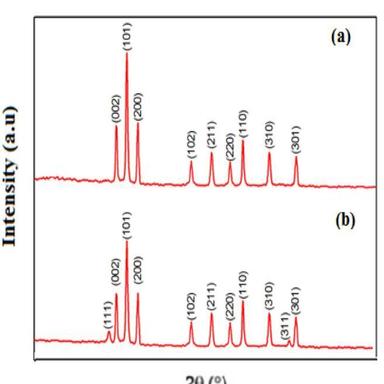
XRD pattern of (a) SnO2 and (b) CdO-SnO2 nanocomposite material.